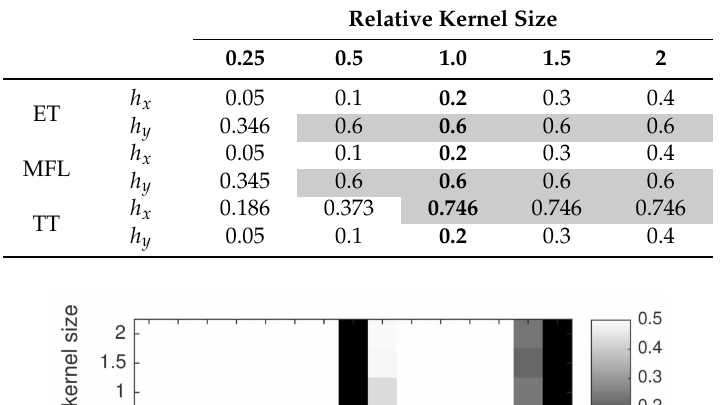
Table 3. Kernel sizes used in the experiment. All sizes are in mm. Relative kernel size denotes the fraction of ˆ u “ 0.2 mm that was used to compute the kernel sizes according to Equation (4). That is, a range of smaller and larger kernels compared to the default size (relative kernel size = 1, bold faced column) were assessed. To prevent unrealistically large kernels due to the disproportionate spatial sampling distances in our data, kernel sizes were limited to 0.6 mm for ET and MFL, and to 0.75 mm for TT (gray shaded table cells).